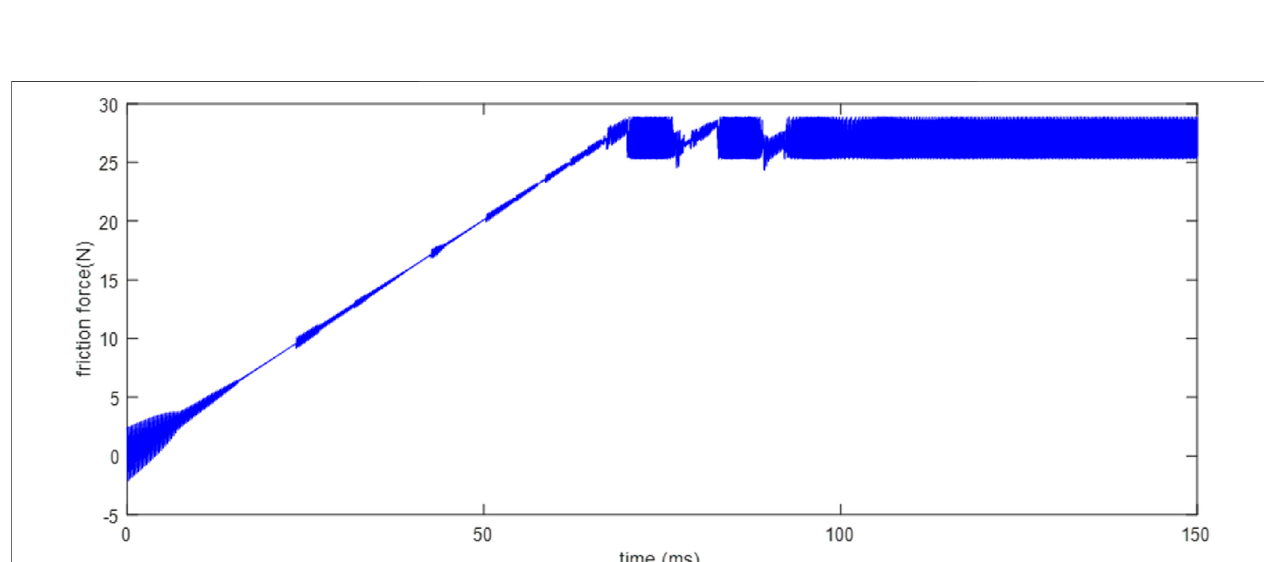
FIGURE 11 | Instantaneous friction force experienced by the pin as it is being driven the by stage for the case of µ i (cid:2) 0.5.